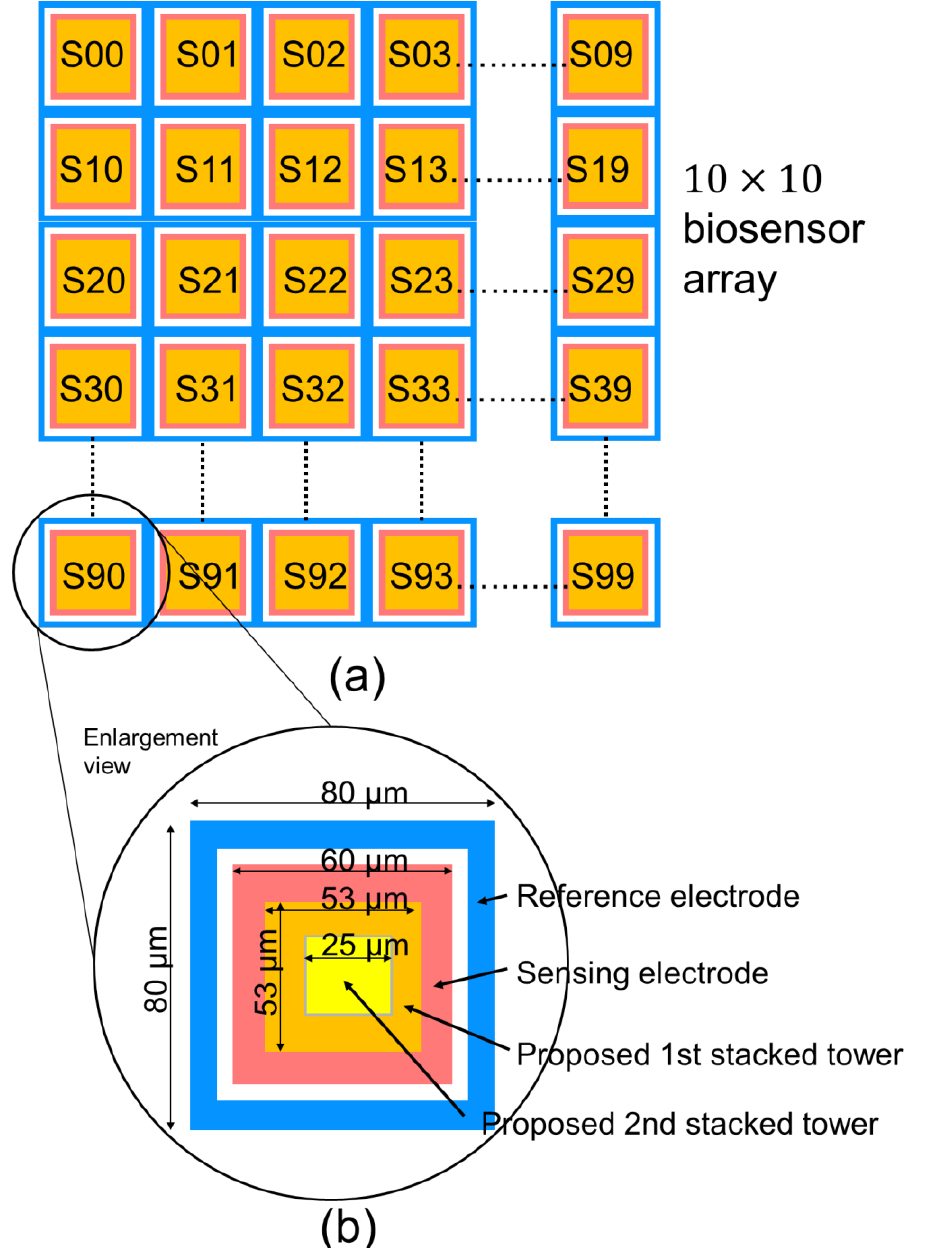
Figure 5. The proposed ( a ) MEMSbased 3D stacked tower 10 × 10 biosensor array and (b) geometry dimensions.